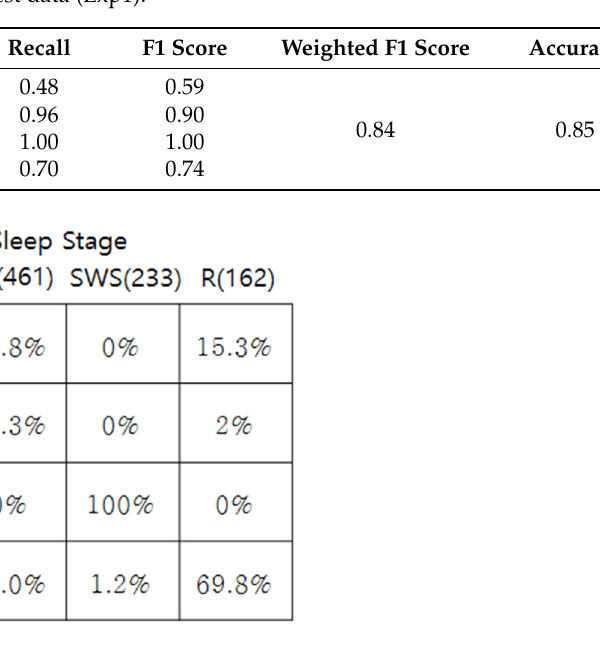
Table 2. Experiment results for test data (Exp1).